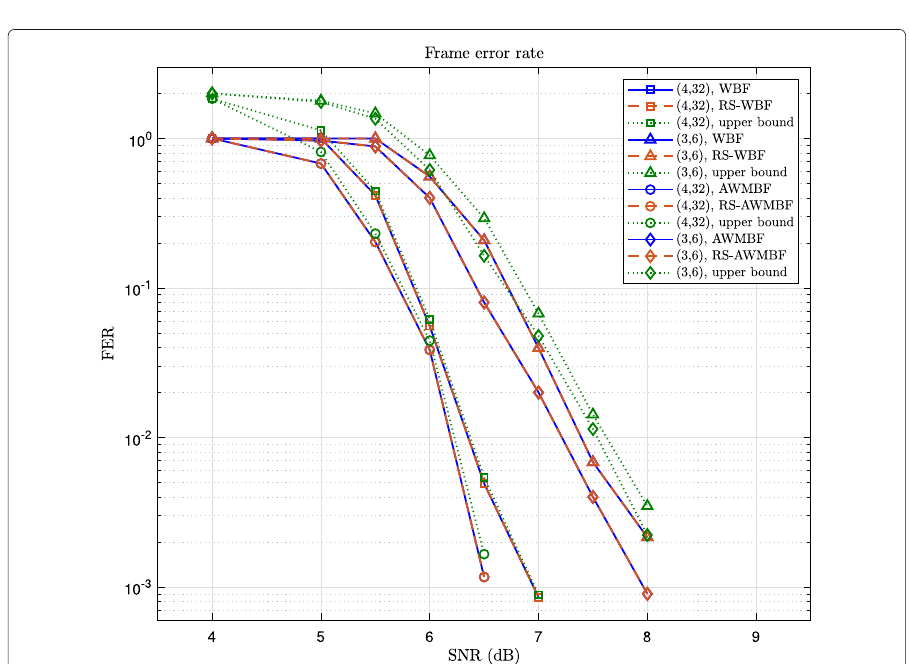
Fig. 6 The FER and the upper bound of (cid:5) P versus SNR for the (3,6) and (4,32)-regular